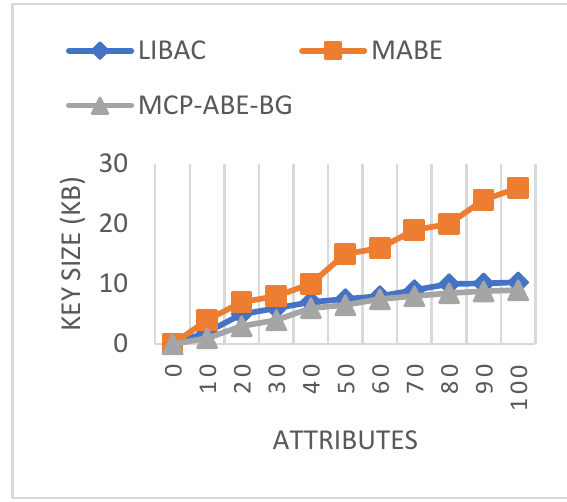
Figure 10. Private key size comparisons.